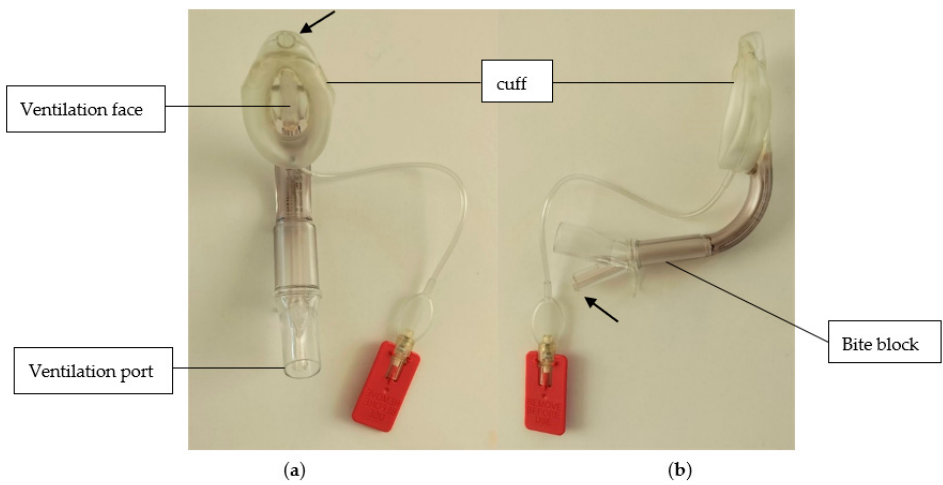
Figure 3. ( a ) Frontal and ( b ) lateral views of the laryngeal mask, LMA Supreme ™, used in this study. The narrows indicate the tube for the drainage of the stomach ( a ) and the gastric access port ( b